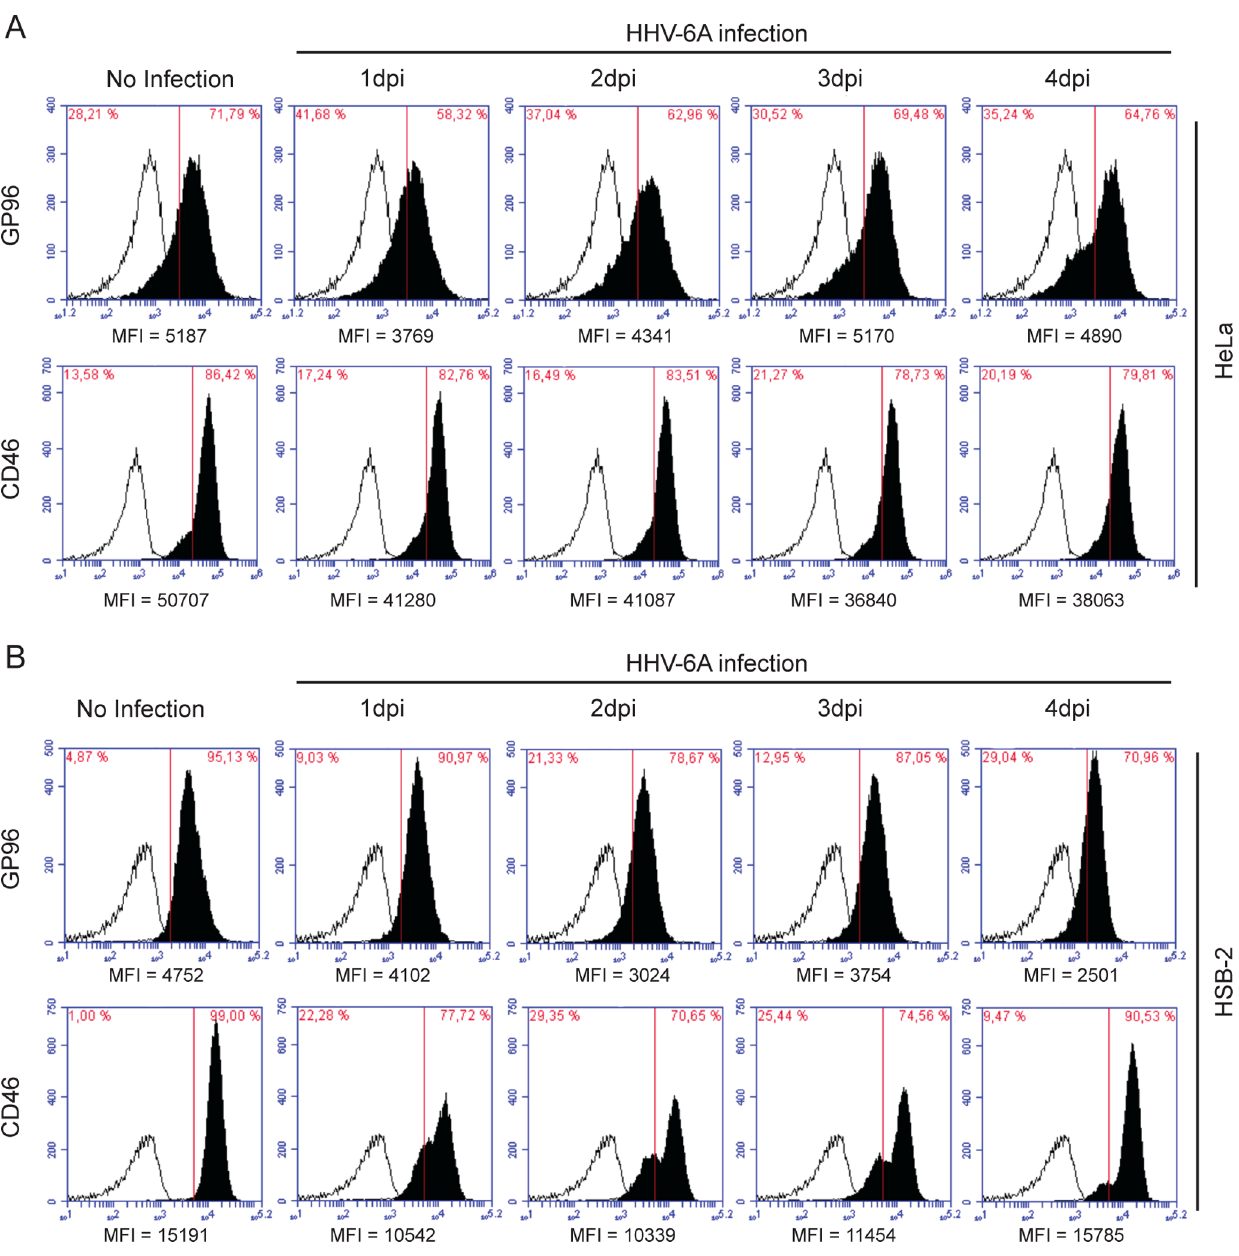
Figure 5. Cell surface expression of GP96 is modulated during HHV-6 infection. Cell surface expression dynamics of GP96 and CD46 in response to HHV-6A infection was determined in ( A ) HeLa and ( B ) HSB-2 cells. Cells were infected with HHV-6A for indicated time points and cell surface expression of CD46 and GP96 was performed by flow cytometry (solid profiles); background fluorescence levels were measured using an isotype specific antibody (empty profiles). Mean fluorescence intensity (MFI) for each analysis is indicated below the respective